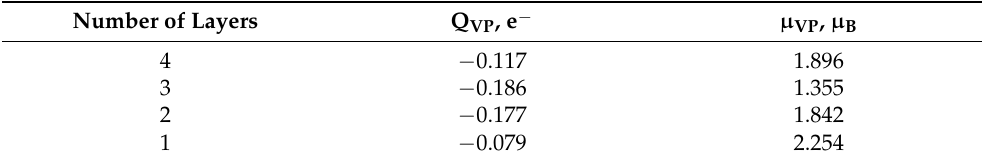
Table 4. Charge (Q VP ) and magnetic moment ( µ VP ) of VP slab in VP/ZnO composites according to Bader